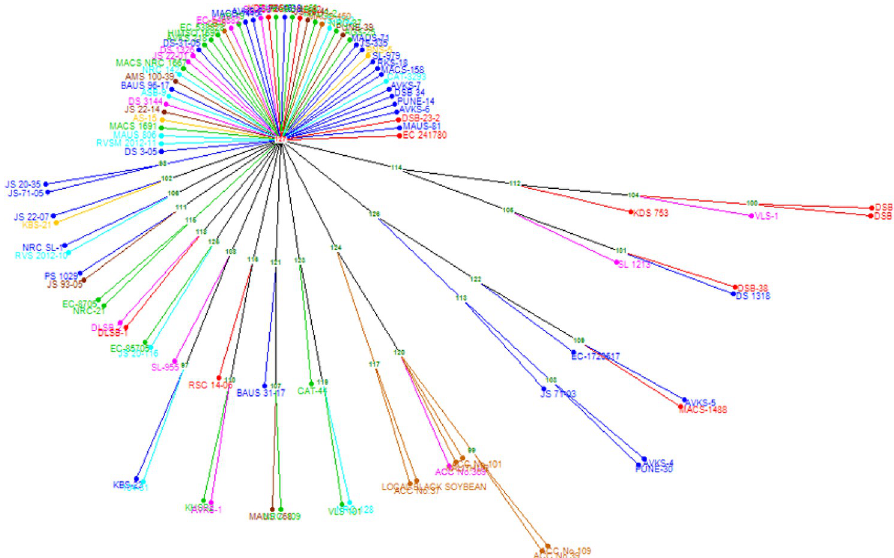
Fig 5. UPGMA cluster of 96 soybean genotypes using SSR markers.